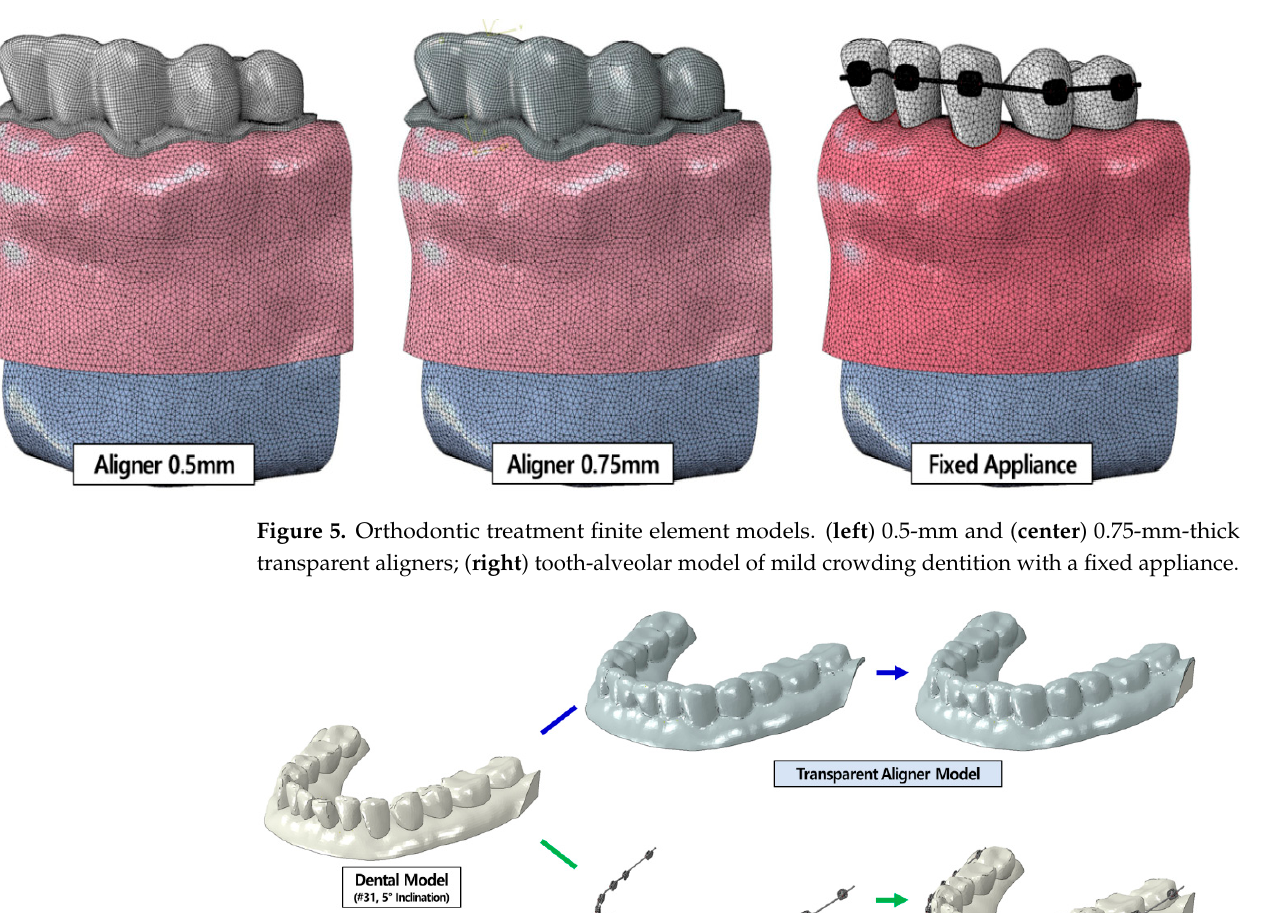
Figure 5. Orthodontic treatment finite element models. ( left ) 0.5-mm and ( center ) 0.75-mm-thick transparent aligners; ( right ) tooth-alveolar model of mild crowding dentition with a fixed appliance.